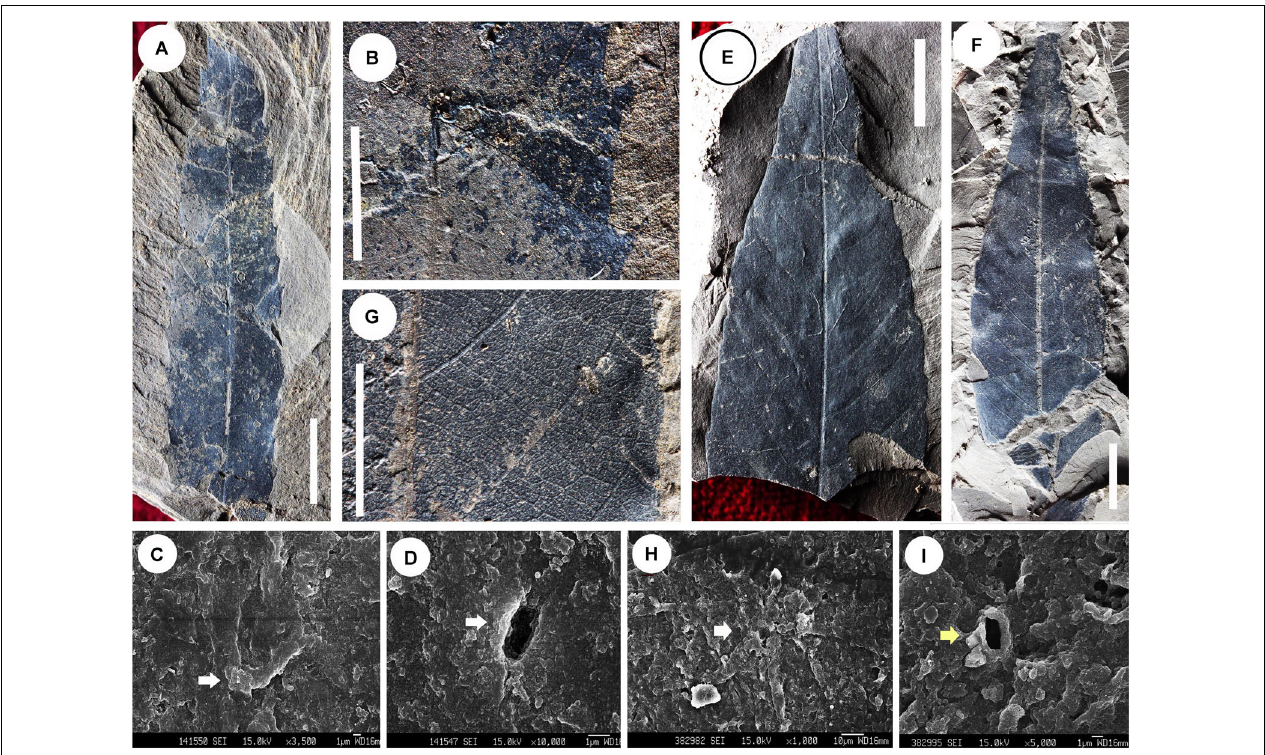
FIGURE 12 | Morphology of Quercus cf. myrsinifolia Blume (A–D) and Q. paleoargyrotricha sp. nov. (E–I) . (A) Specimen No. CC-1272a, showing the lanceolate leaf morphology; (B) enlargement of (A) , showing the teeth, secondary veins and mix percurrent tertiary veins; (C) SEM image showing the outer surface and a stoma (white arrow); (D) SEM image showing the air hole of a stoma (white arrow); (E) holotype. Specimen No. CC-1287a, showing the morphology of the leaf apex; (F) paratype. Specimen No. CC-961, showing the morphology of the leaf; (G) enlargement of (F) , showing the tooth, secondary veins and mix percurrent tertiary veins; (H) SEM image showing the stellate trichome (white arrow); (I) SEM image showing the air hole of a stoma (yellow arrow). Scale bars: 10 mm (A,E,F) ; 5 mm (B,G) .